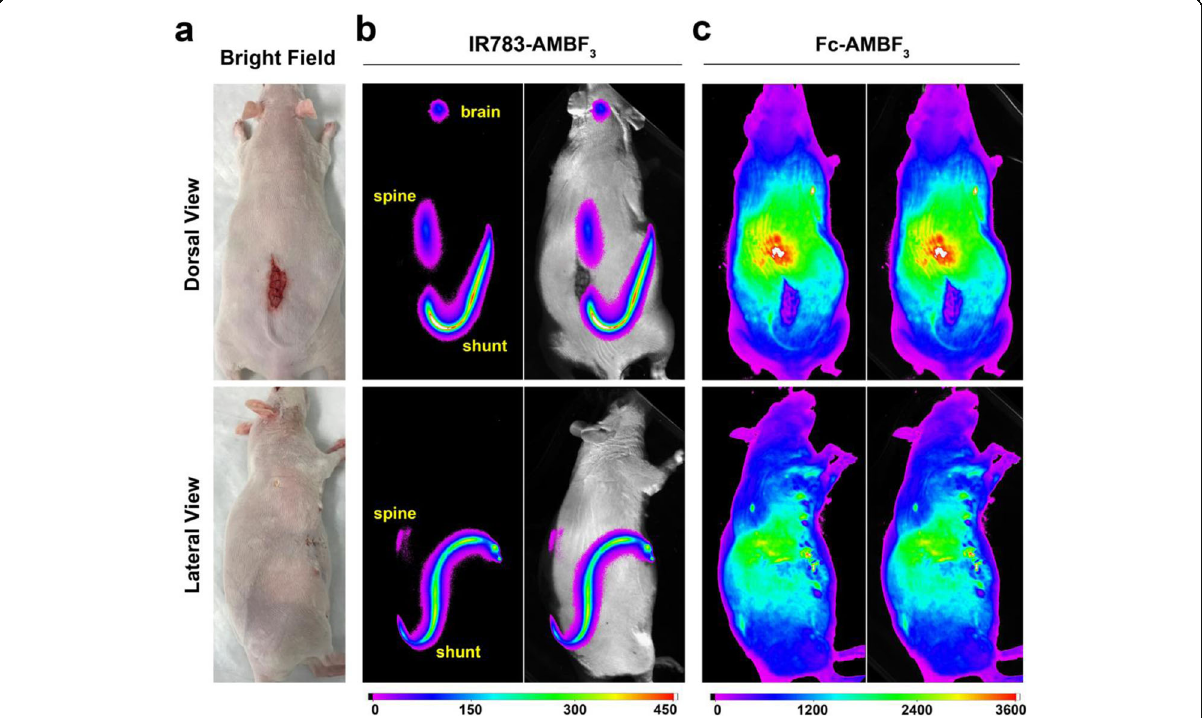
Fig. 3 Non-radioactive IR783-AMBF 3 can be visualized through deep tissue in the fluorescence mode. a Bright field images of rats ( n = 2) with LP shunts that run superficially, under the skin of a shaved rat. b In vivo fluorescent images of the shunt in a rat after filling the shunt with IR783- AMBF 3 (10 μ M). c (Control) Comparative in vivo fluorescent imaging of a shunt filled with Fc-AMBF 3 placed in a rat (1 mM, L5-L6). IR783-AMBF 3 fluorescence is visible in the shunt, spine, and brain, and through skin, bone, and a viable